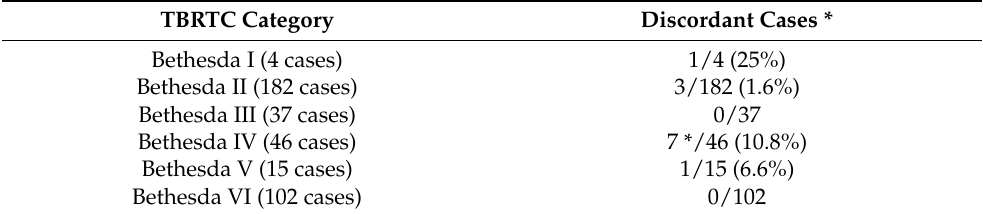
Table 6. Cytologic/histological evaluation of the discrepancies between cytology and histopathology in larger